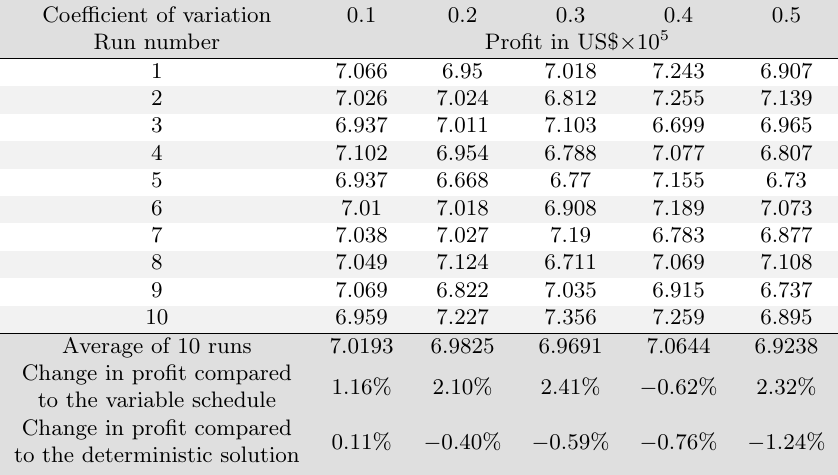
Table 12: Profit from fixed schedule and random